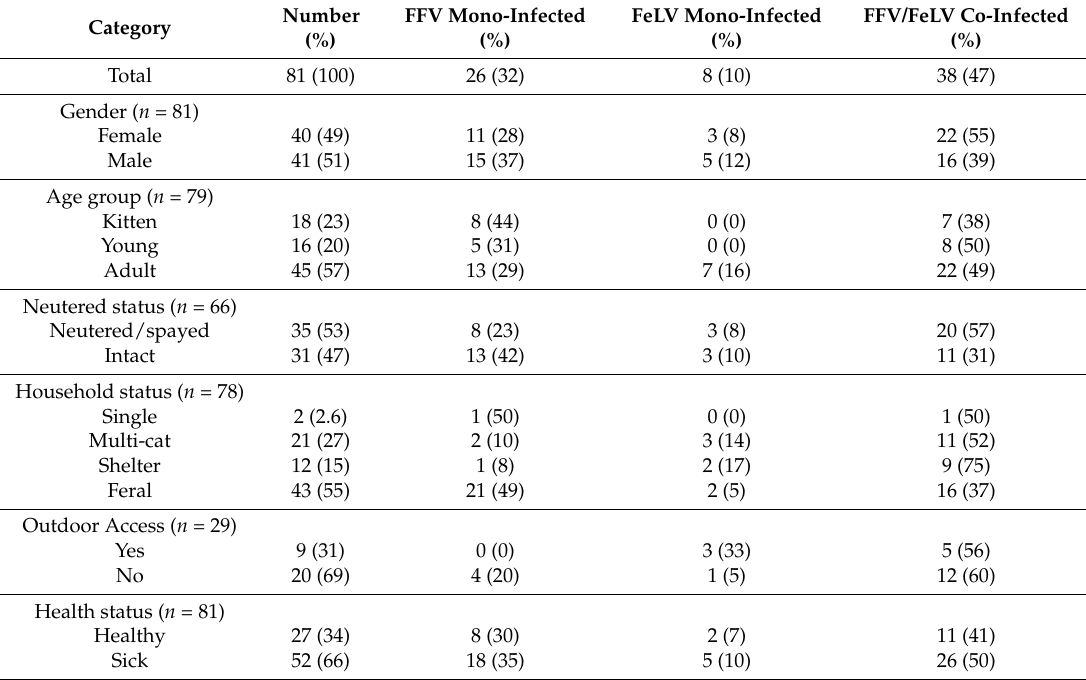
Table 2. Socio-demographic data and FFV and FeLV prevalence a of domestic cats from Brazil in the present study.